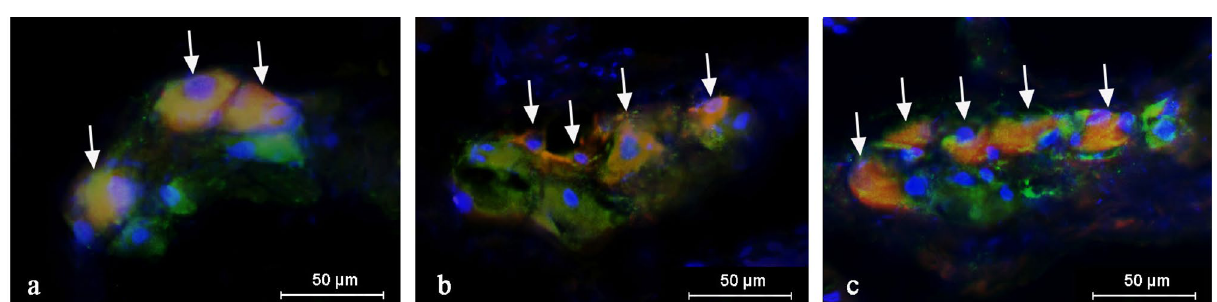
Figure 2. Intramural ganglia in the porcine urinary bladder in control animals ( a ) and animals treated with low ( b ) and high ( c ) doses of bisphenol A, labeled against pan-neuronal marker PGP 9.5 (green), vasoactive intestinal polypeptide—VIP (red) and a marker of cell nuclei-4 ′ ,6-diamidino-2-phenylindole (DAPI) (blue). VTP-positive neurons are indicated with